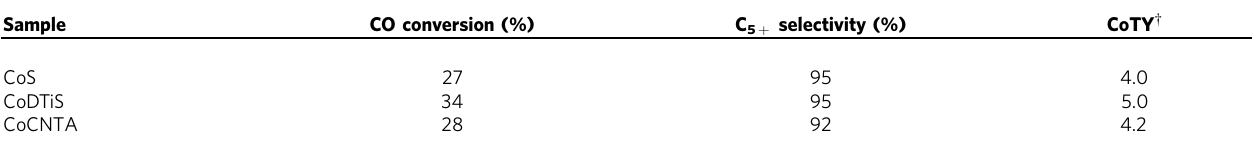
CoTY, cobalt time yield; FT, Fischer–Tropsch. *All data wereobtained after 20h of time on stream wherestable catalytic performance at testingconditions wasachieved. Reaction conditions: reactiontemperature ¼ 215 o C, gas hourly space velocity (GHSV) standard temperature and pressure (STP) ¼ 3,600mlg cat (cid:2) 1 h (cid:2) 1 , H 2 /CO ¼ 2, pure syngas, total pressure ¼ 40bar. The catalysts tested have already been evaluated in the FTreaction at 215 o